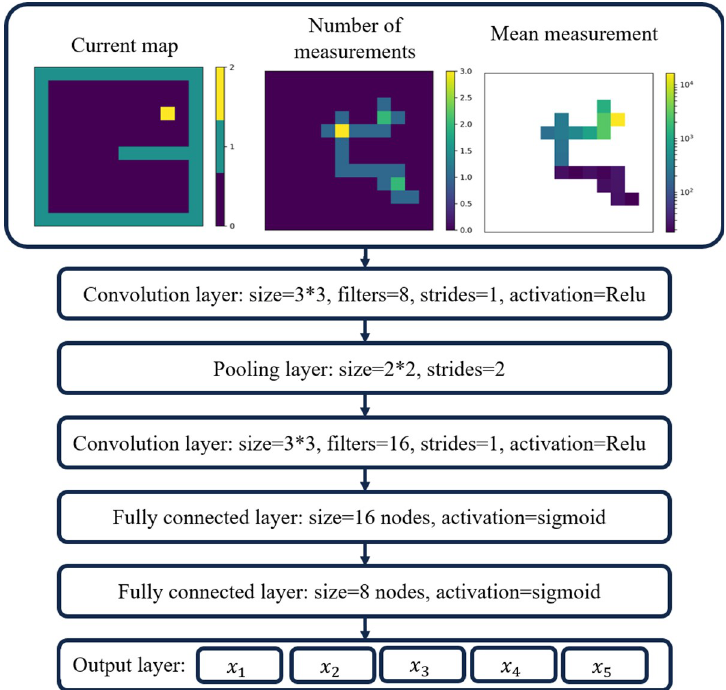
Fig 3. CNN with stopping architecture. Architecture of the CNN with self-stopping. The only difference between this self-stopping network and the navigation only network is the addition of a fifth output representing a termination action. Removing x 5 would yield the network architecture used in